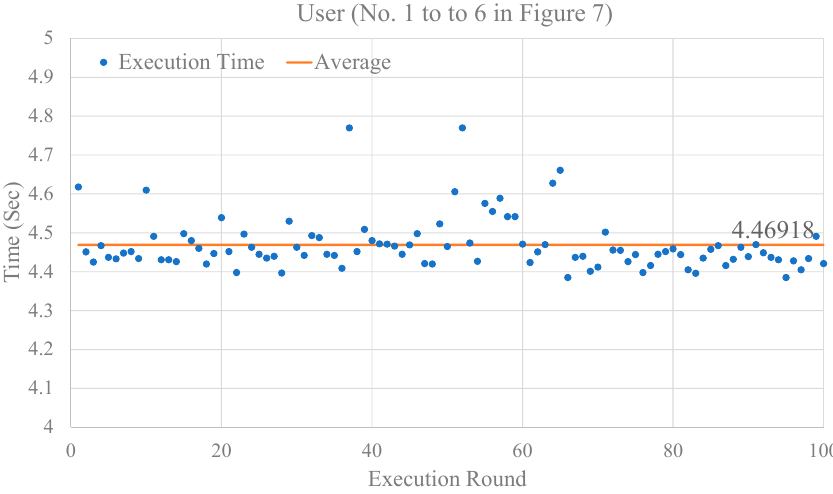
Figure 12. Data-obtaining time in each round for the Hyperledger Fabric part, for the user.